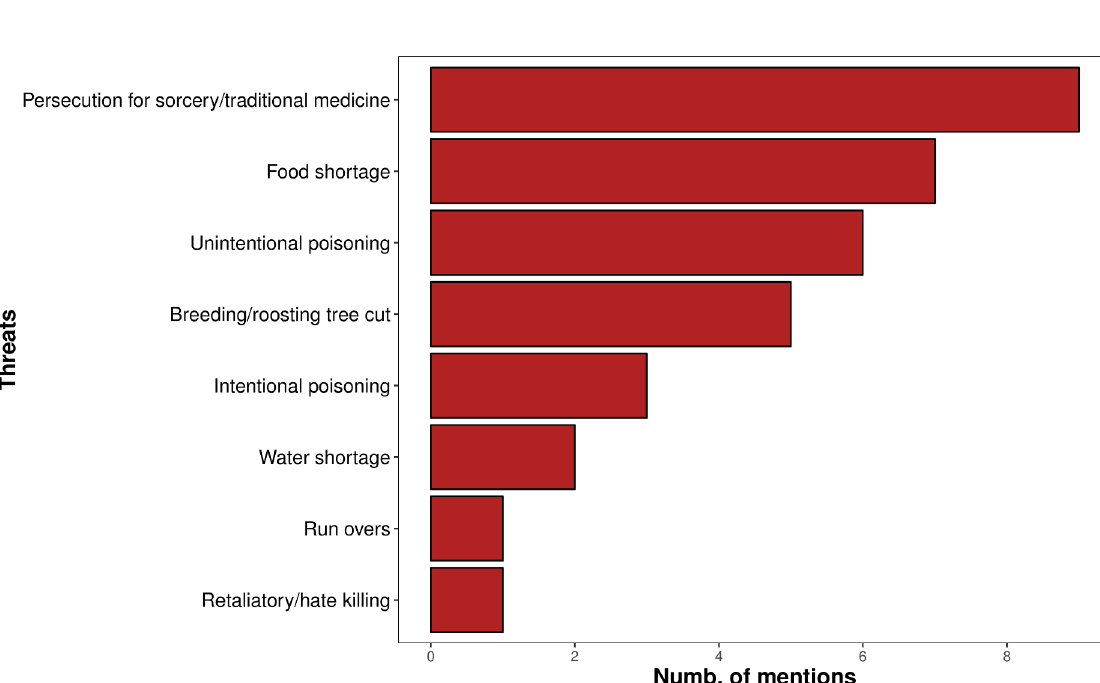
Fig 6. Threat analysis exercise. Threat analysis exercise, showing the number of mentions of each threat. In each interview, respondents could mention more than one threat, thus total exceeds sample size/number of interviews (n = 23).